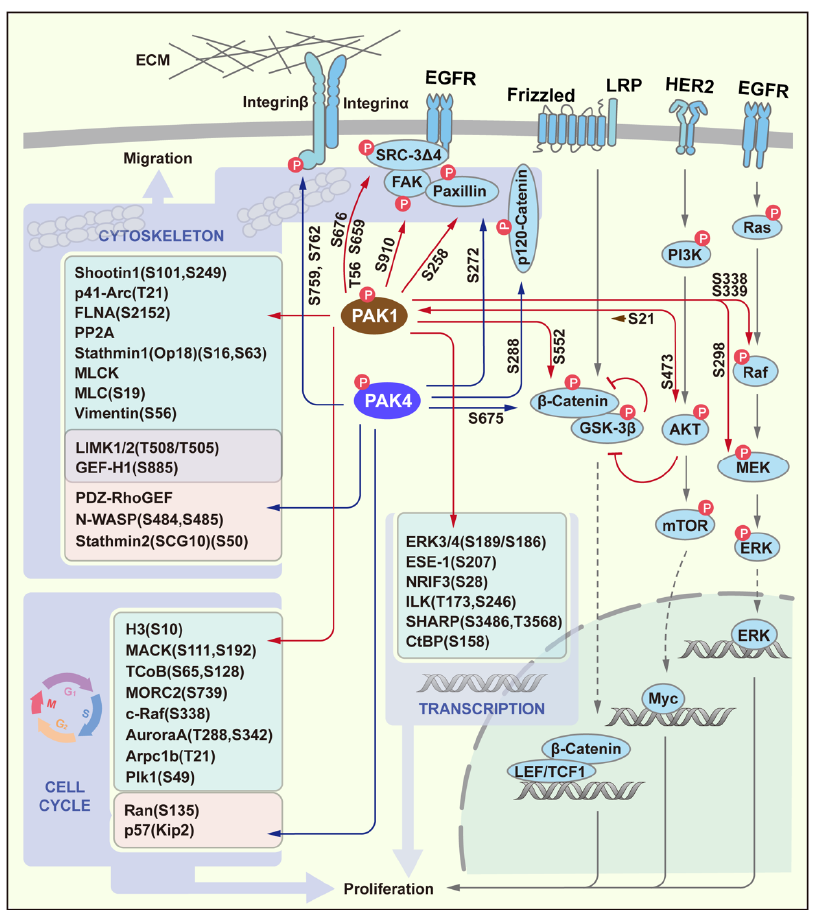
Figure 3. PAK signaling in proliferation and migration. PAK1 participates in the classic MEK/ERK, PI3K/AKT and Wnt/ β -Catenin signaling pathways by phosphorylating key factors to promote cell proliferation. In addition, other PAK target proteins that are involved in the process of cell proliferation via the regulation of transcription or cell cycle are listed in the boxes, respectively. Substrates of PAK1/4 involved in cell migration are listed in the indicated box. The S/T numbers next to the arrowed line segments represent phosphorylation